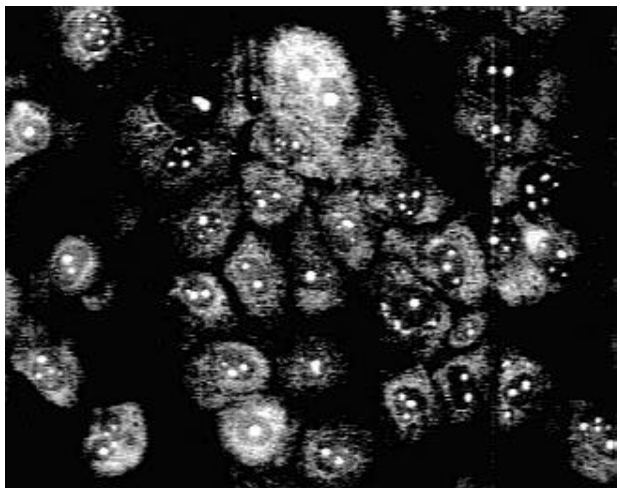
Figure 1. Fluorescence pattern in MDCK-cells after staining with 3a